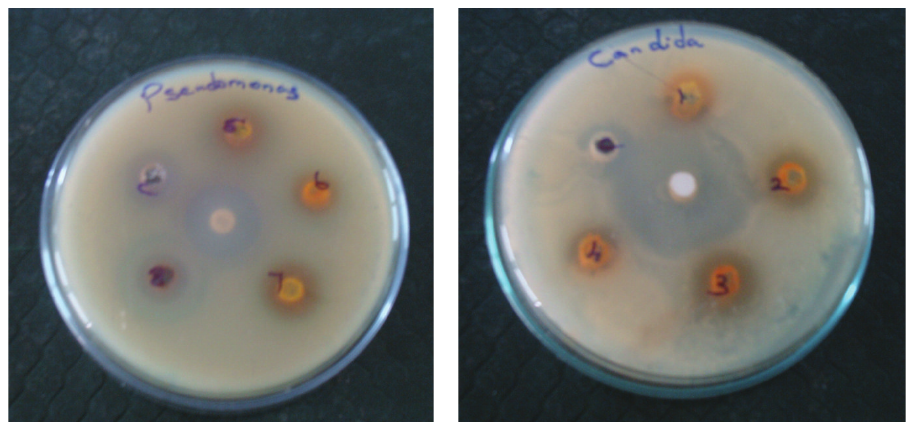
F 7: Fluorescence spectrum of [Cu(CDTMP)